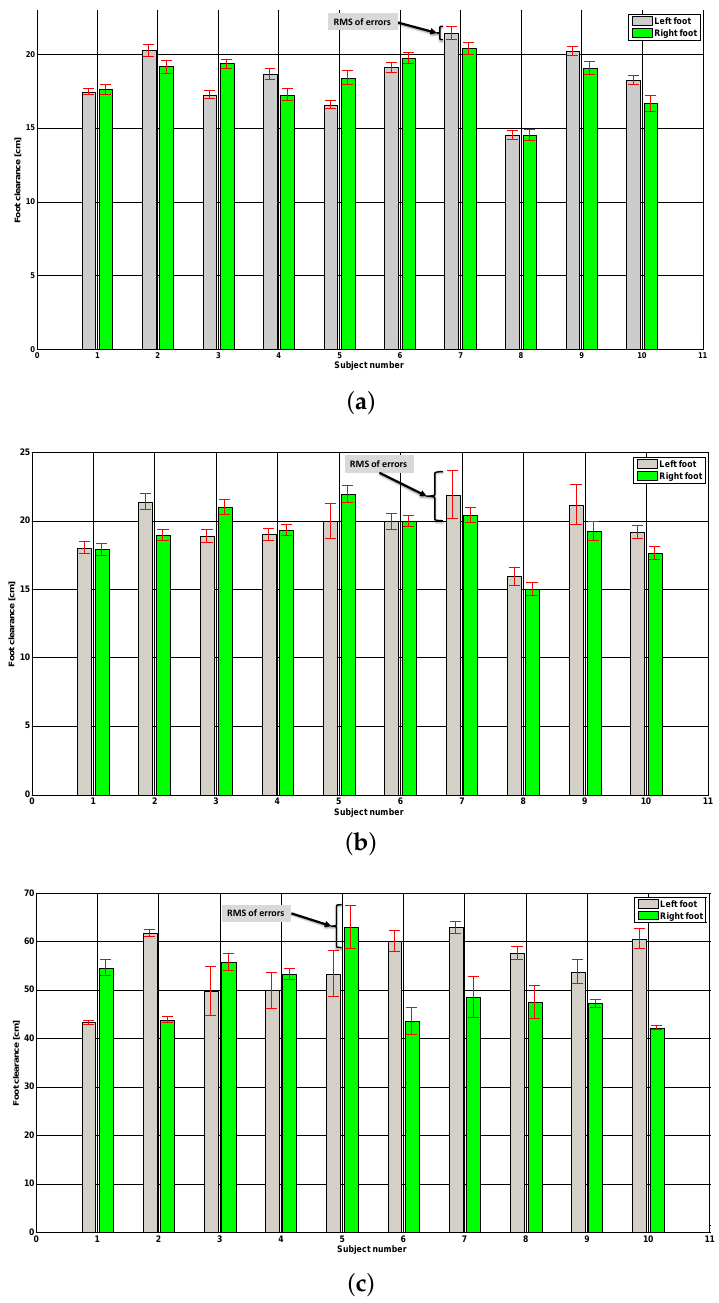
Figure 5. Maximum foot clearance and RMSE between VICON measurements and IMU-based estimates for both feet of each subject during: ( a ) Normal walking; ( b ) Fast walking; and ( c ) Walking with